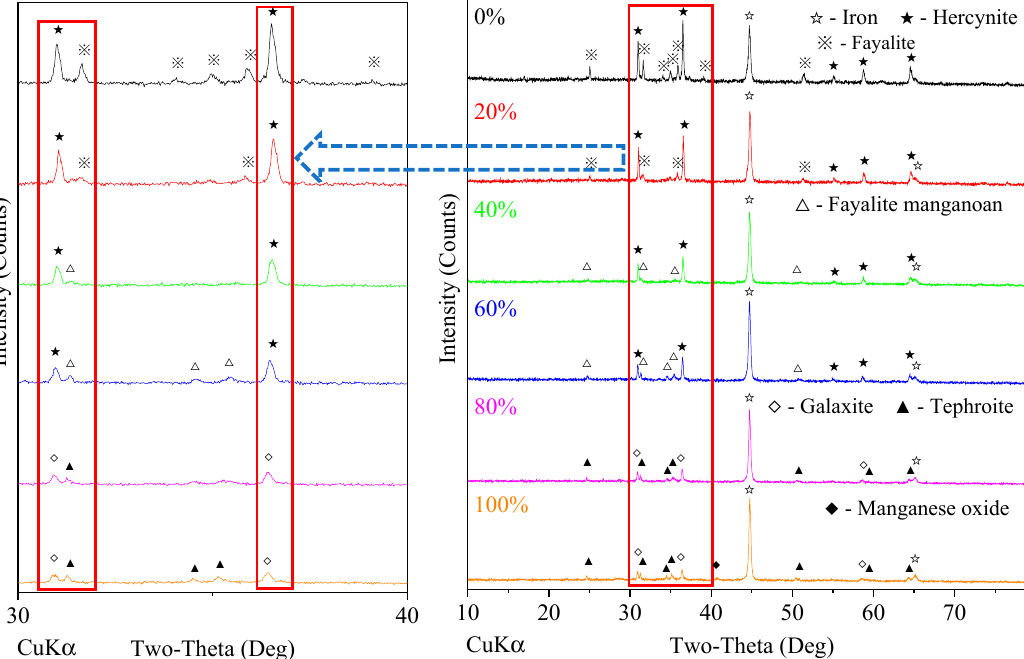
Figure 13. Comparison of standard Gibbs free energy change of reactions between Al 2 O 3 and SiO 2 with MnO and FeO. Another simulation based on the compositions of different HM ore ratio was processed by FactSage7.1, and the results are plotted in Figure 14. Less Fe 2 SiO 4 and FeAl 2 O 4 are produced by increasing the HM ore ratio, while by contrast, more Fe and Mn-Al-Si compounds are generated. Accordingly, the mechanism of synergistic reducing of HA ore and HM ore shown in Figure 15 can be described as follows: (a) The main iron oxide hematite is deoxidized by CO and the intermediate product FeO forms; (b) FeO reacts with the gangue minerals SiO 2 and Al 2 O 3 to produce Fe 2 SiO 4 and FeAl 2 O 4 ; (c) MnO from HM ore combines with Fe 2 SiO 4 and FeAl 2 O 4 to form Mn 2 SiO 4 , MnAl 2 O 4 and FeO; (d) FeO is reduced to Fe in CO atmosphere. The main products consist of Fe, Mn 2 SiO 4 and MnAl 2 O 4 .